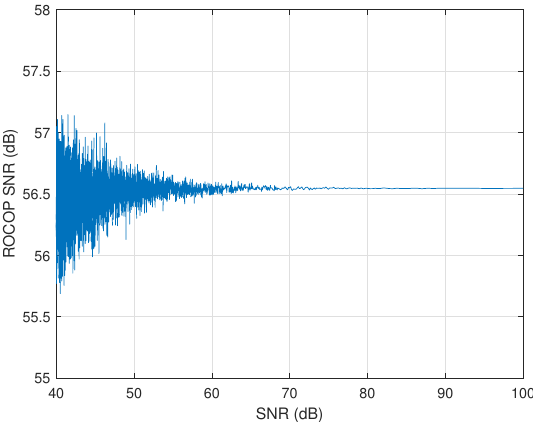
Figure 11. ROCOP SNR versus SNR of I p for arc event